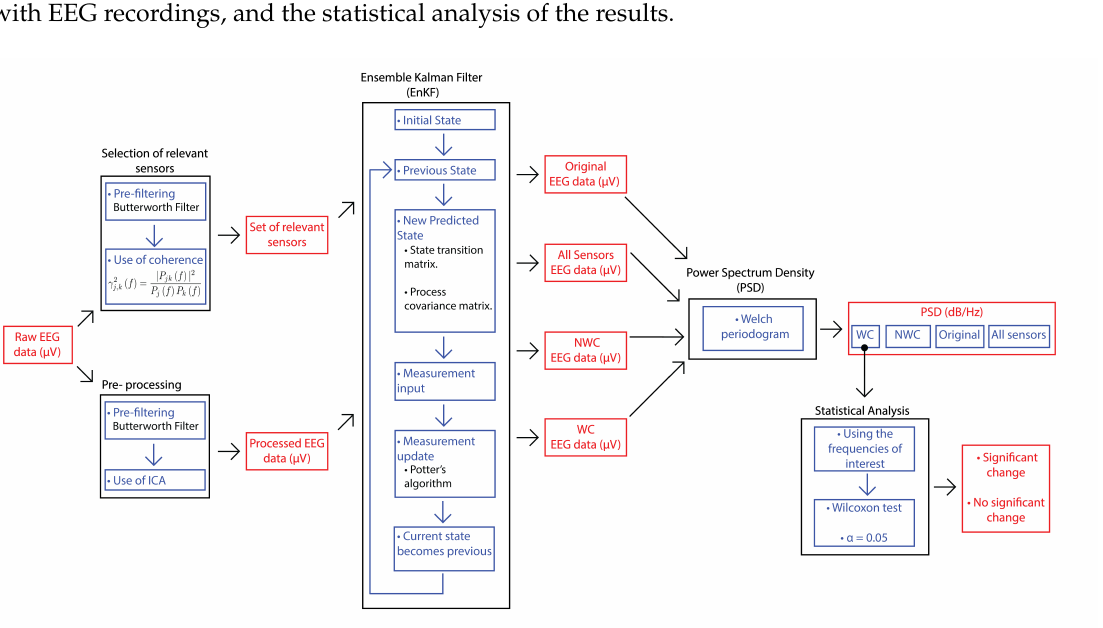
Figure 1. The proposed methodology that combines EnKF and QEEG features.